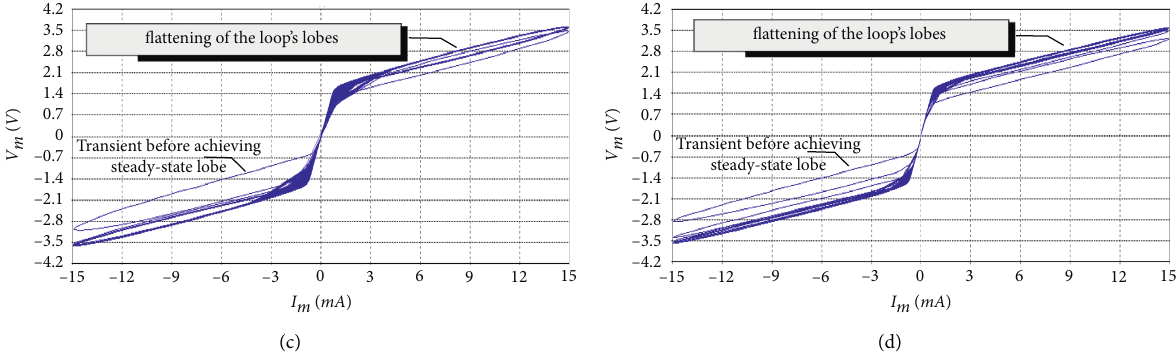
Figure 3: Simulated pinched hysteresis loop of the memristor emulator driven by a current source i amplitude I o � 15mA at different f values: (a) f � 100Hz, (b) f � 500Hz, (c) f � 1500Hz, and (d) f � 3000Hz (100 cycles have been applied for each case study).